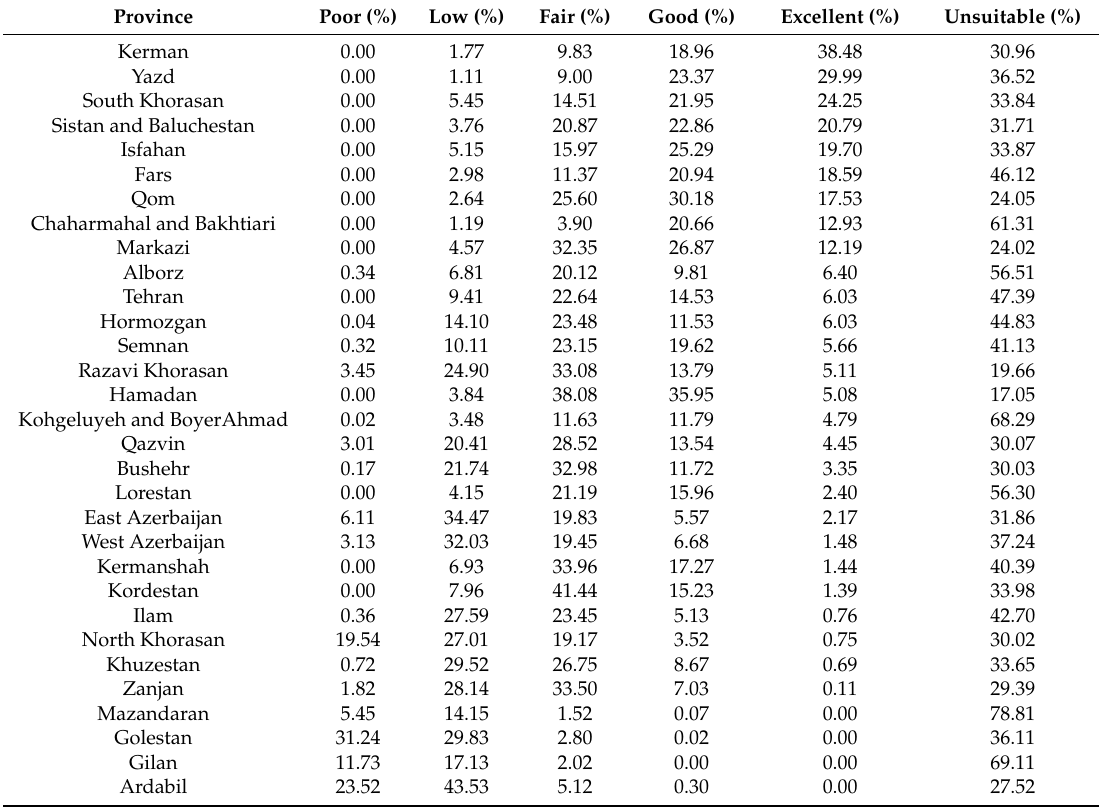
Table 3. The percentage of area related to various classes at the provincial